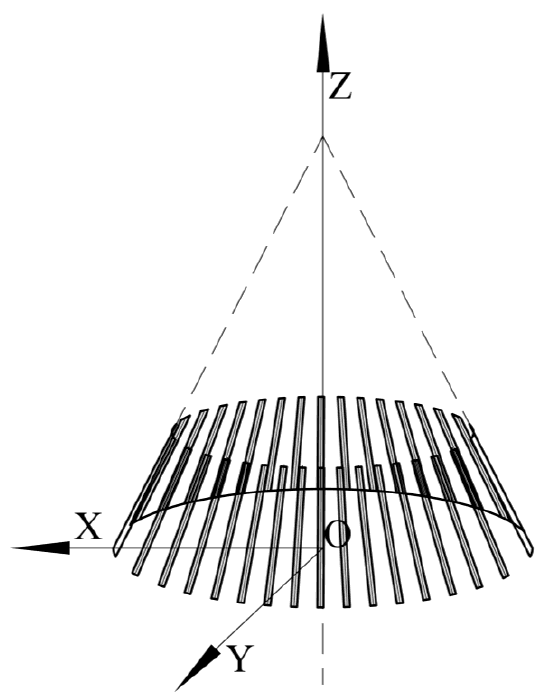
Figure 3. The straight bevel gear top surface model visualization.